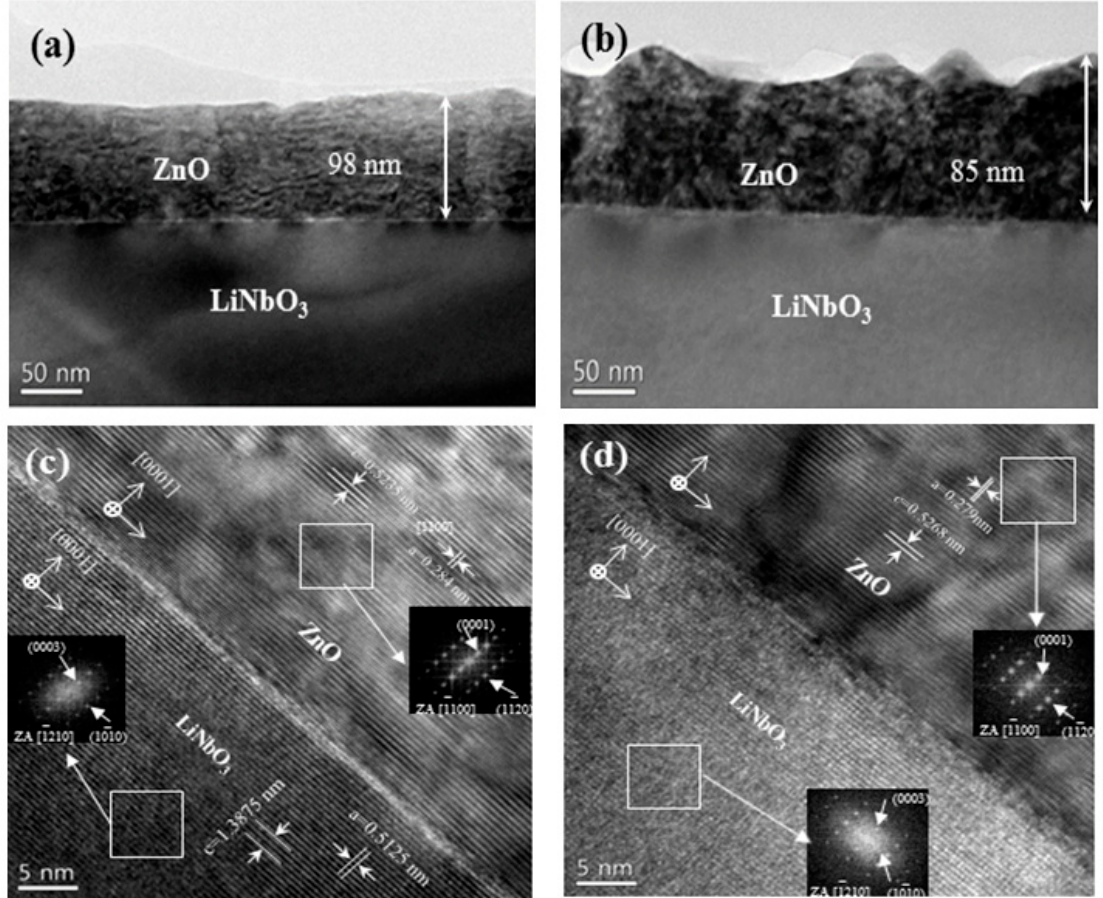
Figure 1. The cross-sectional using high-resolution transmission electron microscopy (HR-TEM) image of the ZnO films grown on the lithium niobate (LiNbO 3 ). ( a ) The cross-sectional TEM image of the ZnO films grown on ( + z) LiNbO 3 ( a ) and on (-z) LiNbO 3 ( b ), respectively. The magnified cross-sectional image of the HR-TEM for the ZnO films grown on ( + z) LiNbO 3 ( c ) and (-z) LiNbO 3 ( d ), respectively. The insets of Figure 1c,d show the selected-area di ff raction pattern from the ZnO films and the LiNbO 3 , respectively.